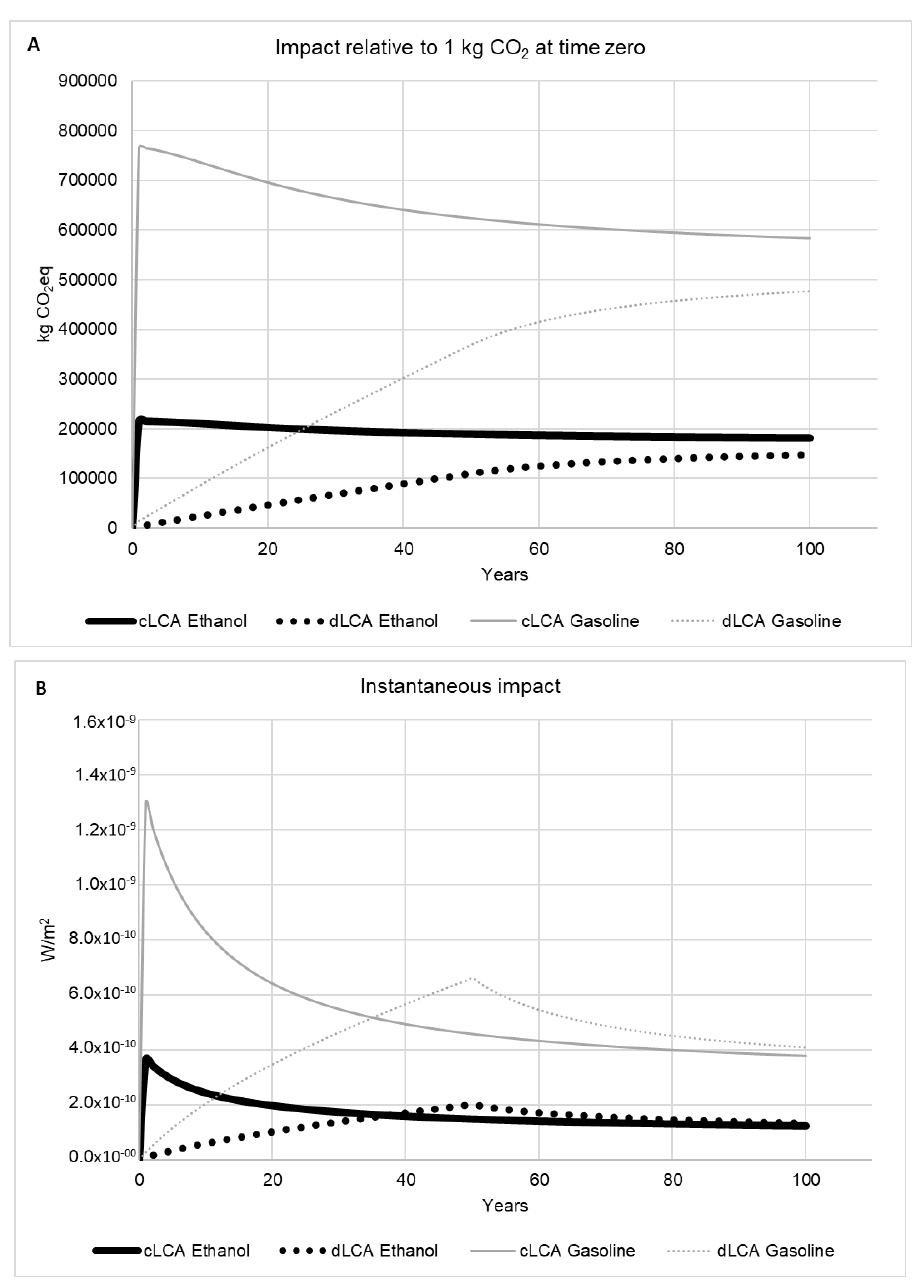
Figure 6. Relationship between productivity and emissions from different simulated scenarios, considering possible genetic modification of yeast strains. Results for the present study only include TRACI values (see Table 5).